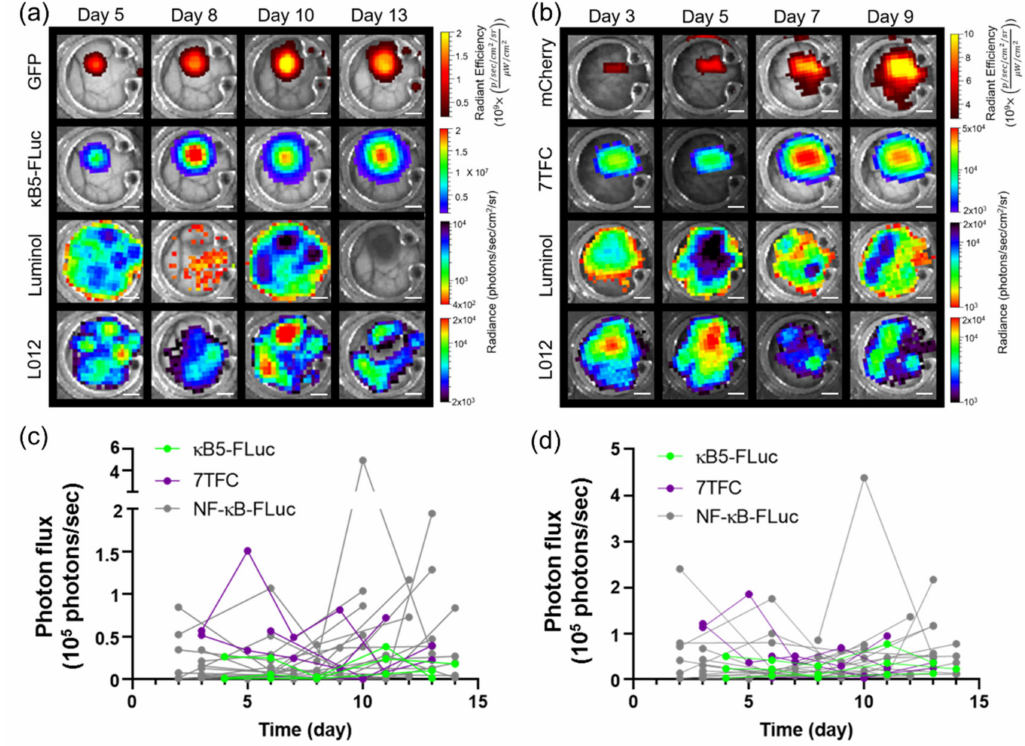
Figure 3. In vivo bioluminescence unmixing in wild type window chamber-bearing animals with different B16F10 signaling reporter cells. Representative unmixed in vivo window chamber imaging over time of ( a ) B16F10 κ B5-FLuc GFP reporter cells ( n = 3 animals) and ( b ) B16F10 7TFC-mCherry reporter cells ( n = 4 animals). GFP or mCherry fluorescence monitored B16F10 tumor growth. Reporter activation was monitored by FLuc bioluminescence ( κ B5-Fluc or 7TFC) following D- luciferin i.p. injection. Innate immune cell infiltration imaged by bioluminescence using luminol and L-012; scale bar represents 2 mm. Longitudinal bioluminescence quantification as a function of time of ( c ) luminol and ( d ) L-012 in window chamber-bearing animals with κ B5-FLuc and 7TFC reporter cells (luminol and L-012 data for NF- κ B-FLuc reporter cells included as